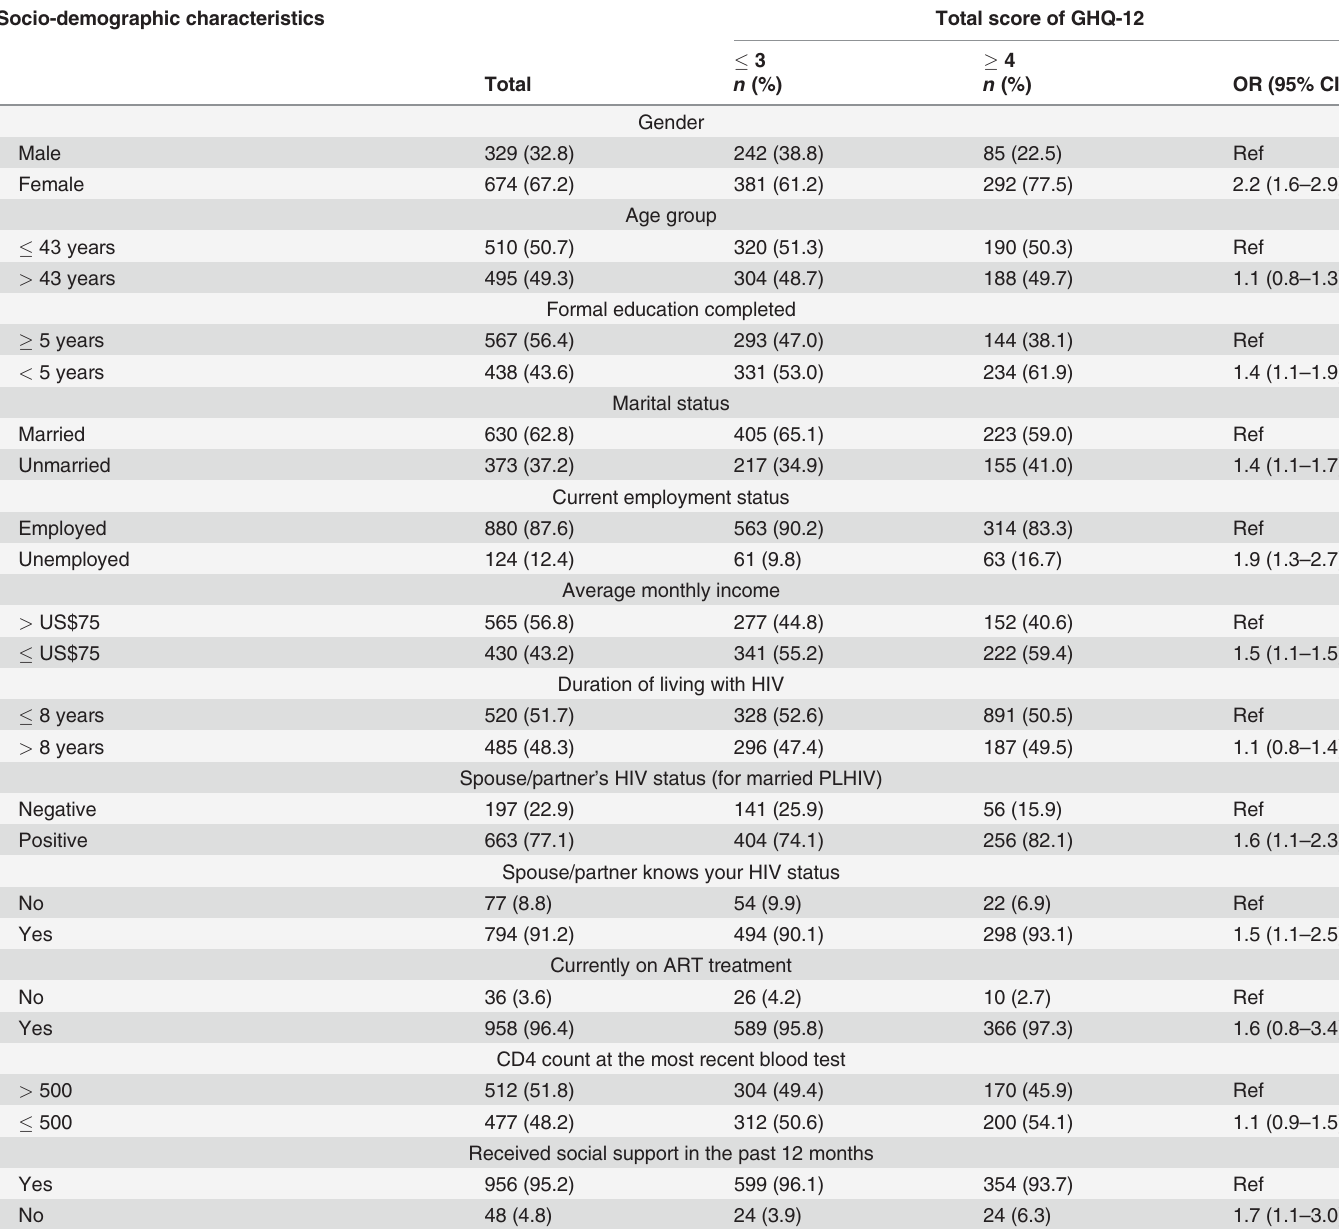
Table 1. Comparisons of socio-demographic characteristics of PLHIV with lower and higher levels of mental disorders. Socio-demographic